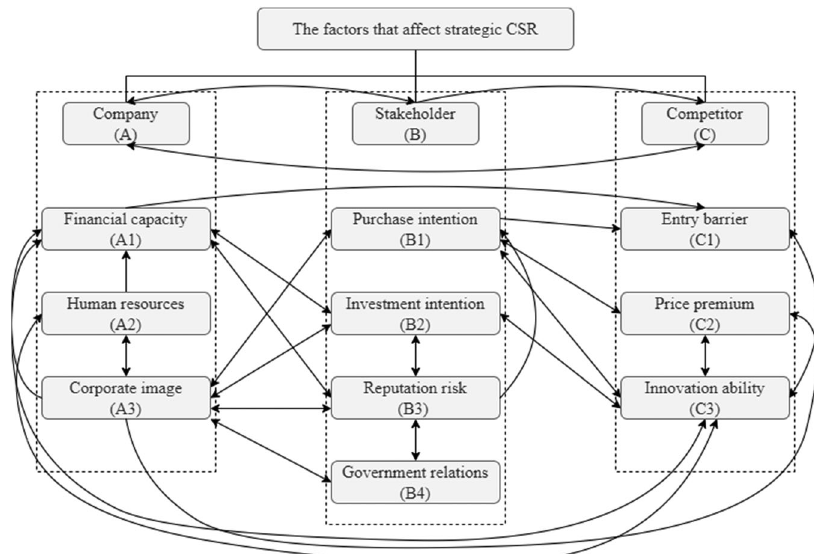
Fig. 1 The hierarchical network structure of this study. It includes three main factors, ten sub-factors, and the interdependence of factors.